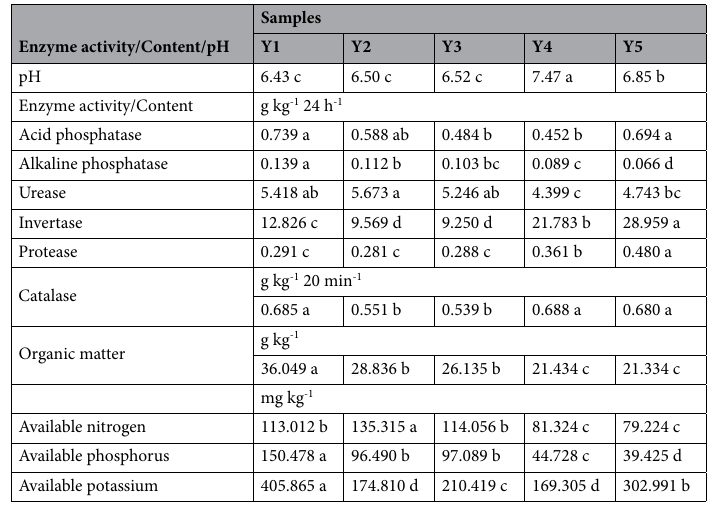
Table 1. Chemical properties and enzyme activities of F. taipaiensis rhizospheric soils with different cultivation years. Different lower-case letters indicate significant differences ( p < 0.05) among the 5